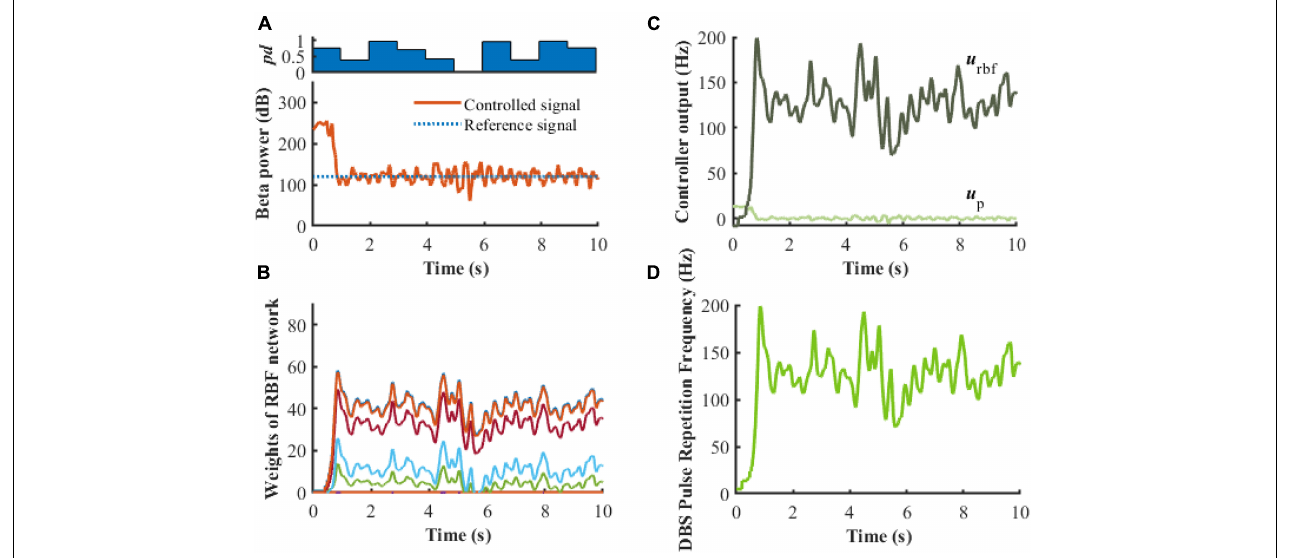
FIGURE 10 | Robustness analysis of the RBF controller in the presence of dynamic changes in the Parkinsonian state ( k p = 0 . 1 ) . (A) Dynamic change of Parkinsonian state is characterized by the parameter, pd . The RBF-controller modulated beta power during dynamic changes is depicted in the bottom panel. Panel (B) shows the evolution of real-time updated weights of the RBF network, (C) plots the trend of P controller and RBF controller, and (D) generates the DBS pulse repetition frequency. Here, the stimulation amplitude is set to 300 µ A / cm 2 and the pulse duration is set to 0.3 ms.